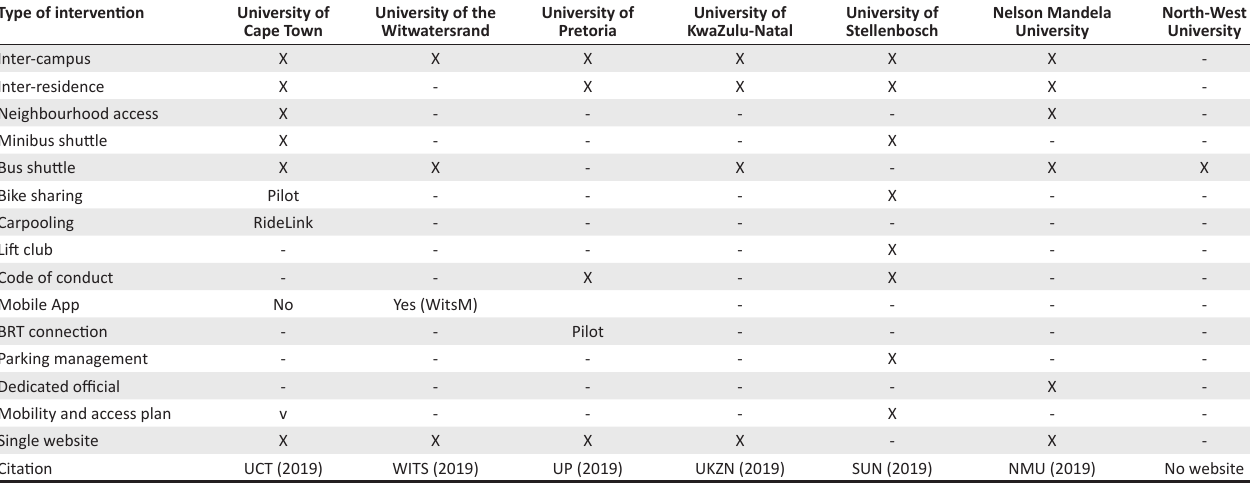
TABLE 1: Mobility interventions in selected universities in South Africa. Type of